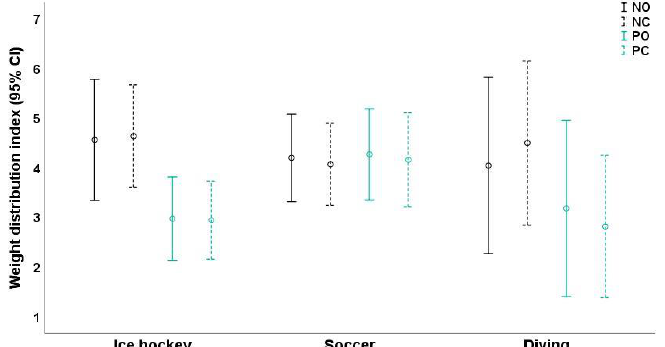
Figure 5. Weight distribution index between sports during four test conditions (NO, NC, PO, PC). Values are provided as mean and 95% CI.